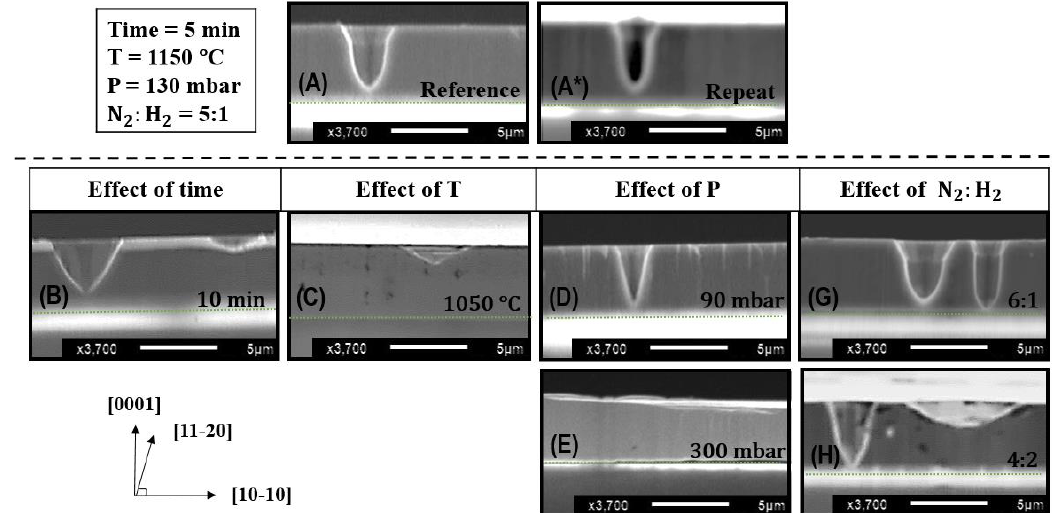
Figure 2. SEM cross-section images of in-situ etched GaN layers at different etching conditions; etching time, temperature (T), pressure (P) and etchant gas flow N 2 : H 2 . The etching parameters of the reference sample ( A ), and a reproduced sample ( A* ), under the same etching conditions are shown in the first row. Correspondingly, one parameter is altered for each sample with respect to the reference sample as ( B ) 10 min in-situ etching time, ( C ) temperature of 1050 ◦ C, ( D ) pressure of 90 mbar, ( E ) pressure of 300 mbar, ( G ) the etchant gas flow ratio 6:1 and ( H ) the etchant gas flow ratio 4:2. The green dashed lines indicate the interface between the sapphire and the GaN